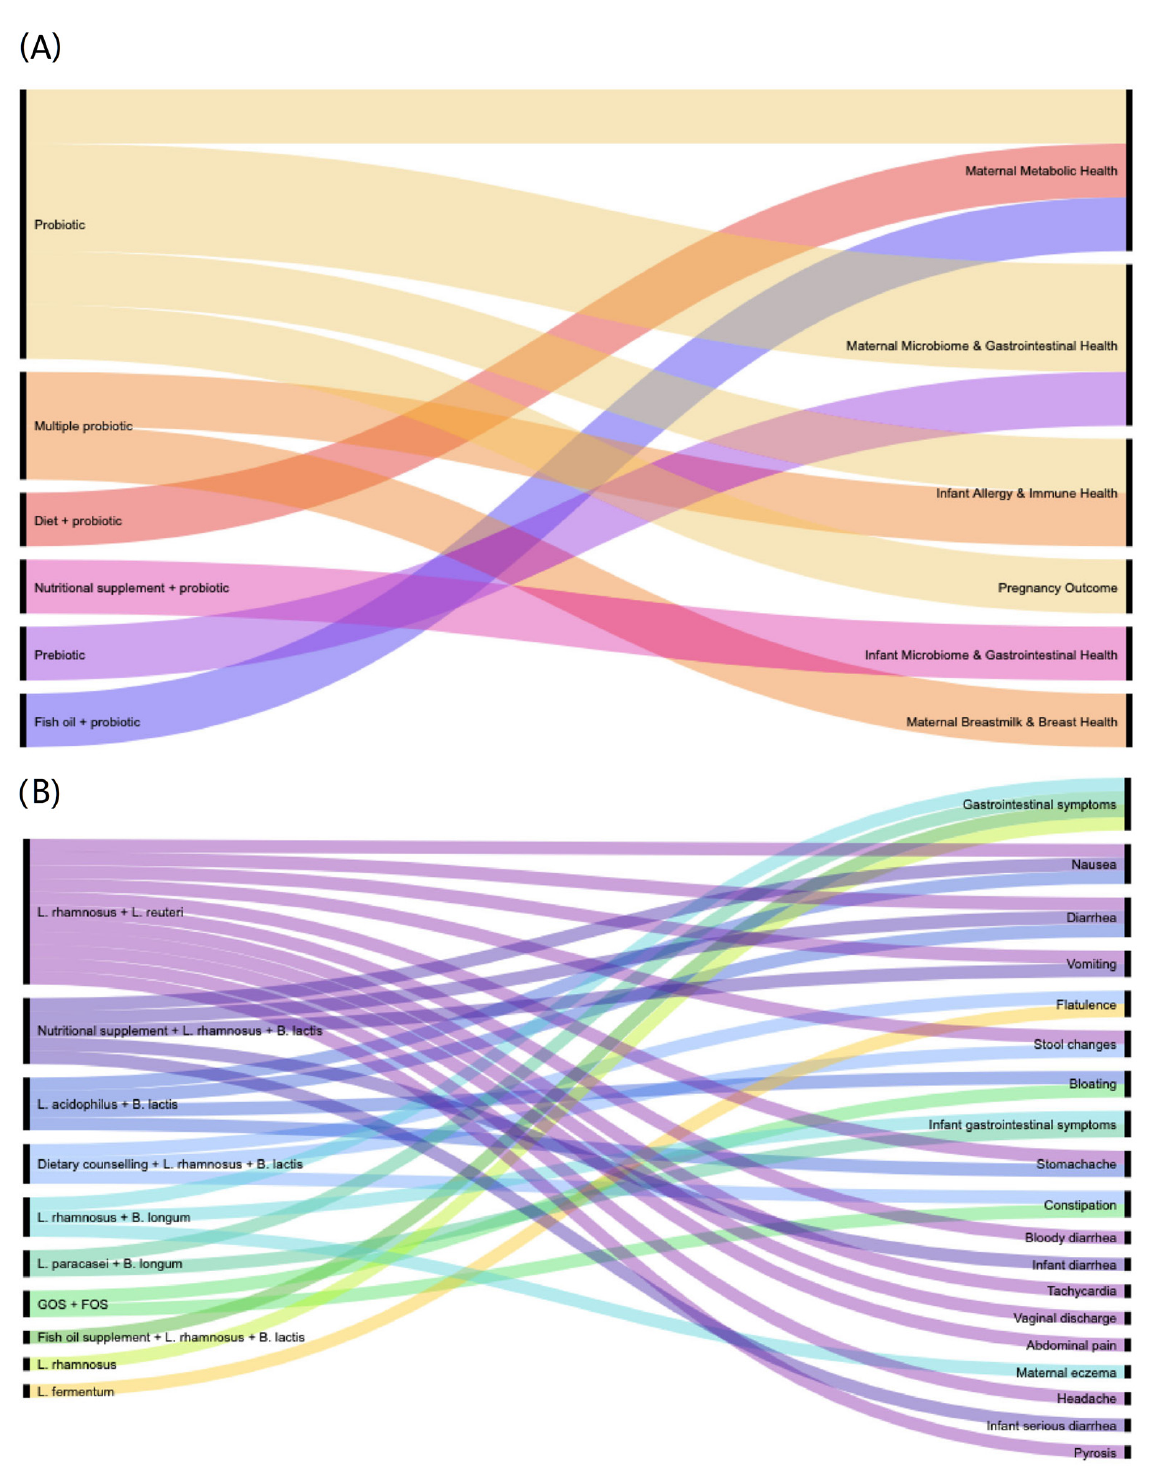
Figure 1. Alluvial diagrams of ( A ) the general intervention type and primary outcome group and ( B ) specific intervention (including probiotic products, prebiotic product, and multi-factorial interventions) and adverse effect type (11 studies with reported adverse effects